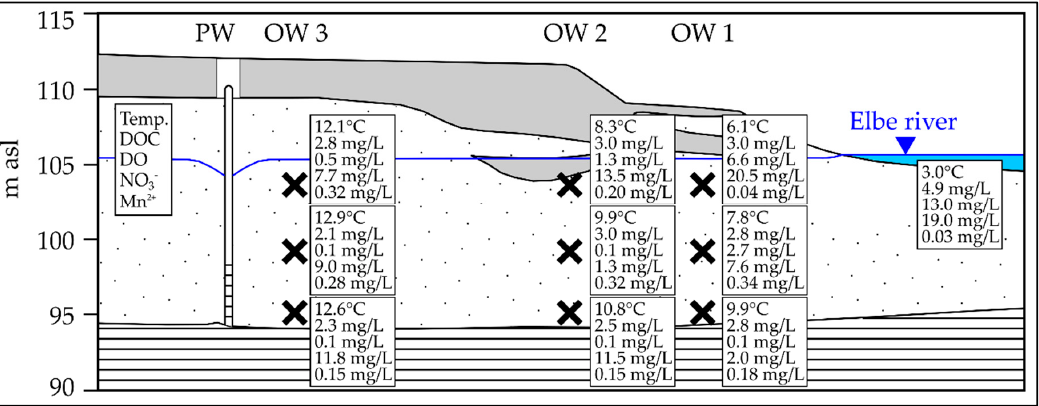
Figure 2. The mean values ( n = 2) of the relevant redox parameters along the transect in February (Table S4).